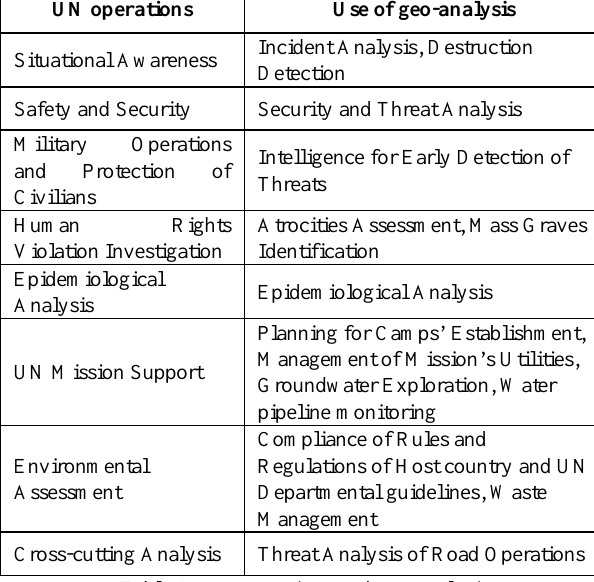
Table 1. UN operations and